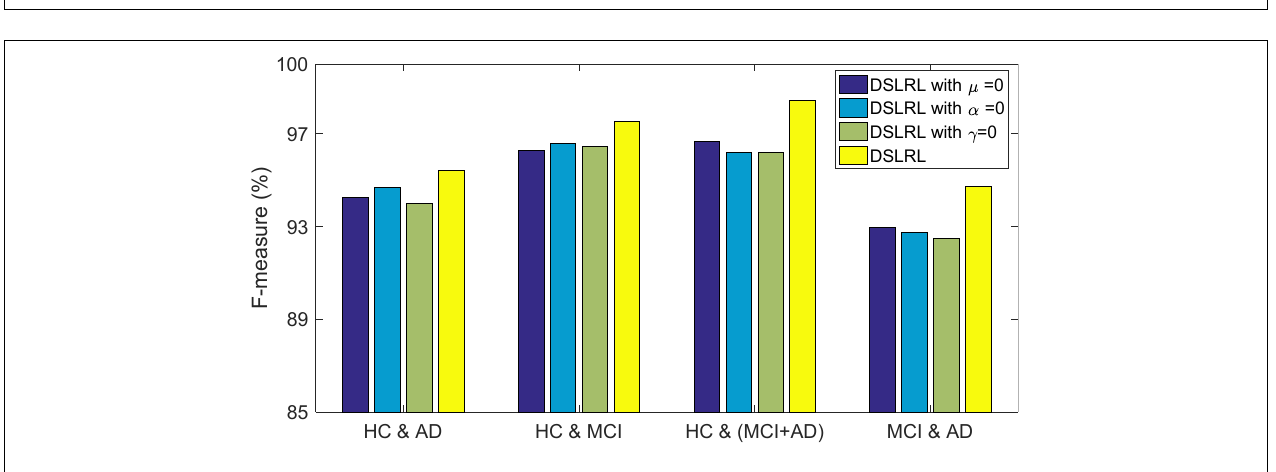
FIGURE 2 | Classification accuracy of DSLRR with ablation experiment in four EEG datasets.